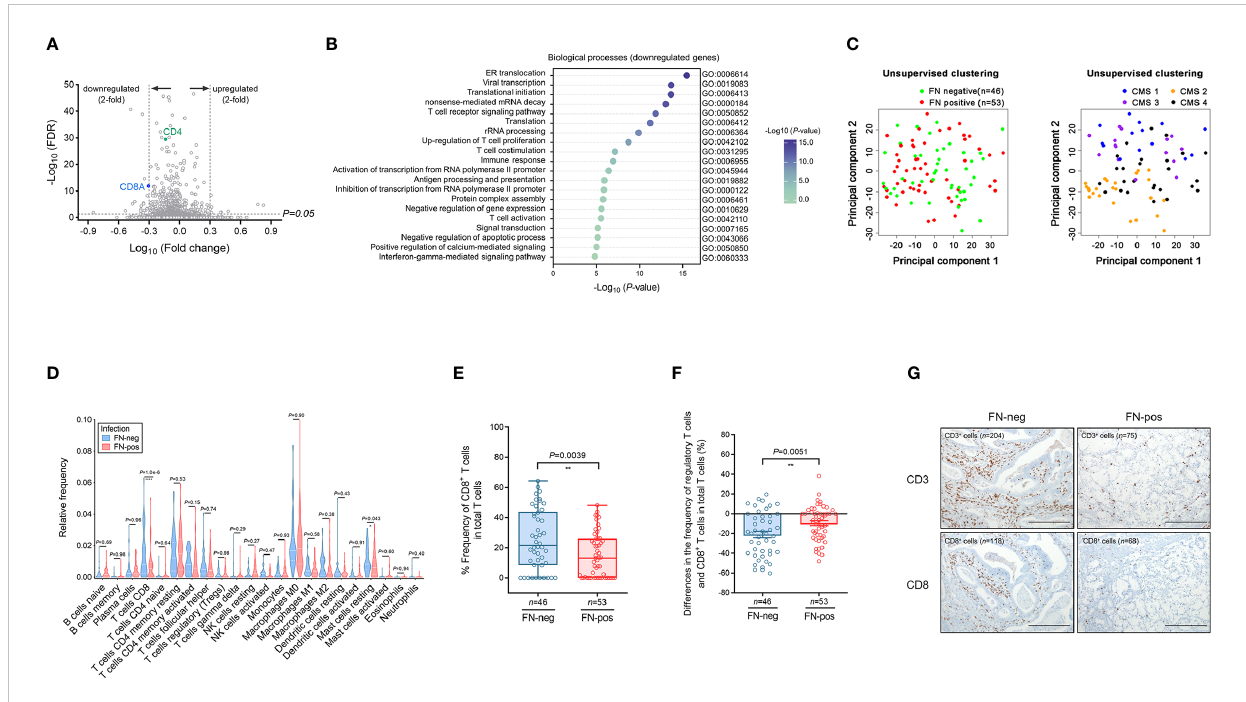
FIGURE 2 Expression pro fi le and immune cell in fi ltration of colorectal cancer according to FN infection. (A) Volcano plot of differentially expressed genes (DEGs) according to FN infection. (B) Gene ontology analysis of the top 20 biologic processes negatively enriched in FN-positive tumor tissues. (C) Unsupervised principal component analysis (PCA) according to FN infection or CMS groups among samples. (D) Immune cell composition of tumor tissues according to FN infection based on deconvolution method. (E) Relative frequency of CD8 + T cells in total T cells of tumor tissues according to FN infection based on deconvolution method. (F) Differences in the frequency of regulatory T cells and CD8 + T cells in total T cells of tumor tissues according to FN infection based on the deconvolution method. (G) Immunohistochemistry for T cell in fi ltration of tumor tissues according to FN infection. Scale bars, 100 m m. Error bars indicate SEM. Statistical tests: * P < 0.05, ** P < 0.01, **** P <